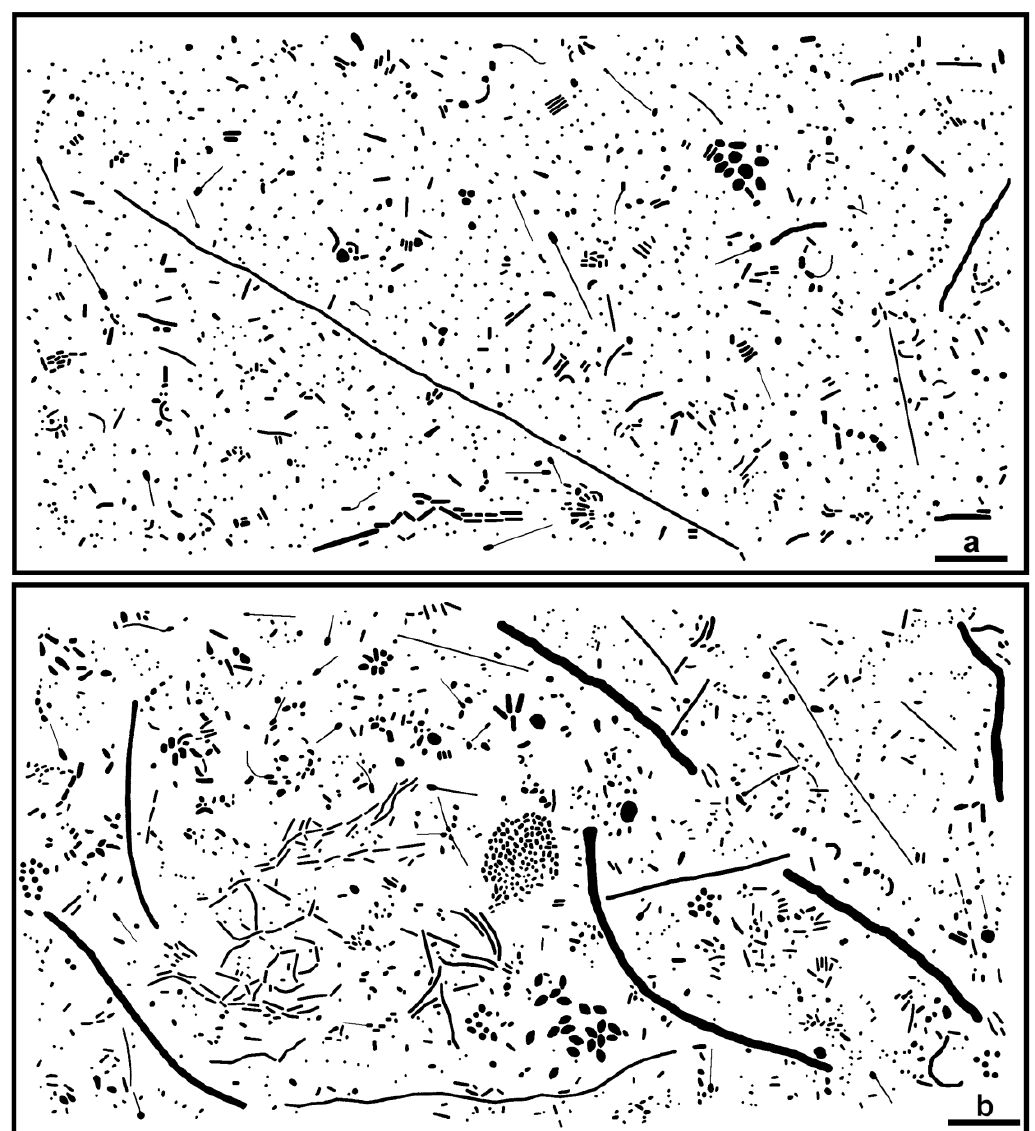
Figure 1. Binary images of natural microbial biofilm assemblages (communities A and B) developing on ( a ) plain glass slides and ( b ) polystyrene plastic slides submerged for four summer days in the Red Cedar River, East Lansing Michigan. Bar scales equal 10 μm.